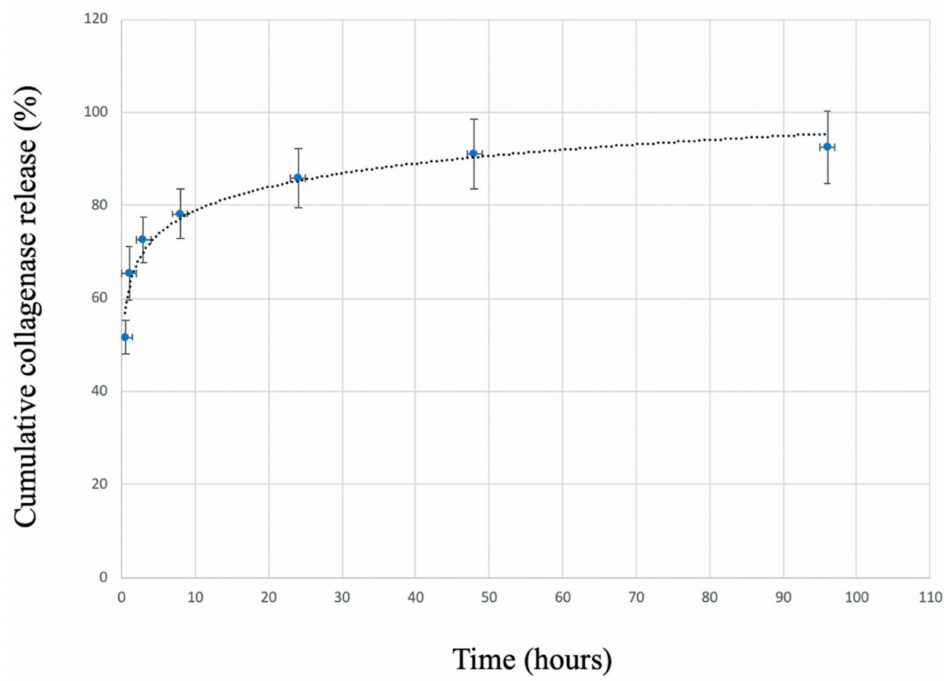
Figure 3. Release profile of the collagenases loaded in C / G / GP hydrogel. The release profile was evaluated by incubation C / G / GP hydrogel in PBS with collagenase concentration of 0.1 mg / mL. The error bars designed the standard